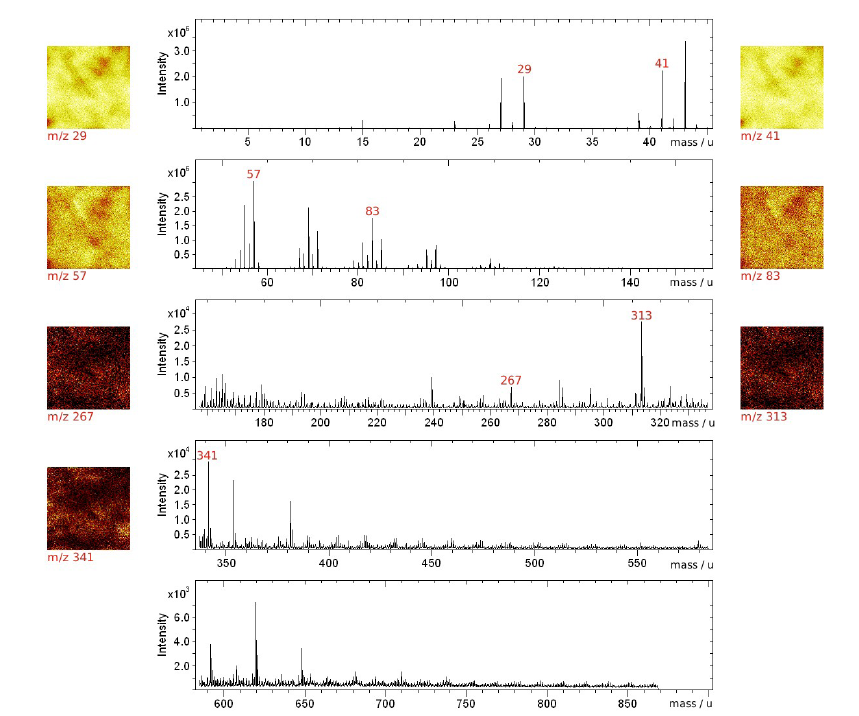
Figure 4. SIMS spectra of hexadecanethiol SAM onto the Ag in positive